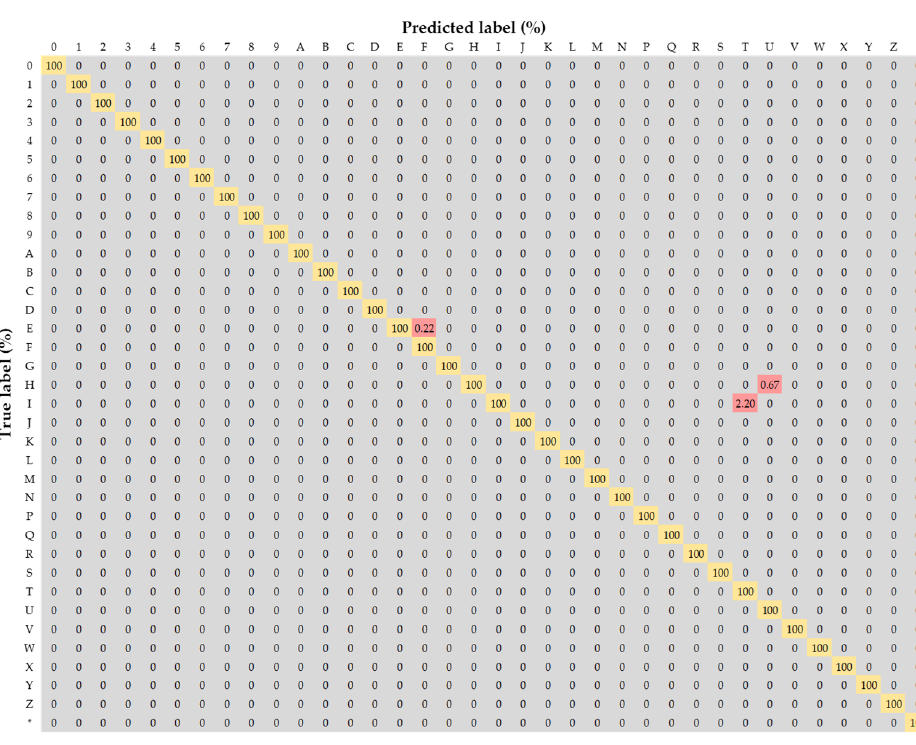
Figure 10. Graphical accuracy comparison for the result of Table 5 (Compared previous studies have marked “N/A” because only classification results exist without character region detection). (a) Zhao et al. [10]. (b) Ebrahimzadeh et al. [11]. (c) Feng et al. [13]. (d) Alwzwazy et al. [16]. (e) Boufenar et al. [17]. (f) Zhao et al. [19]. (g) Wang et al. [21]. (h) Jang et al. [22].